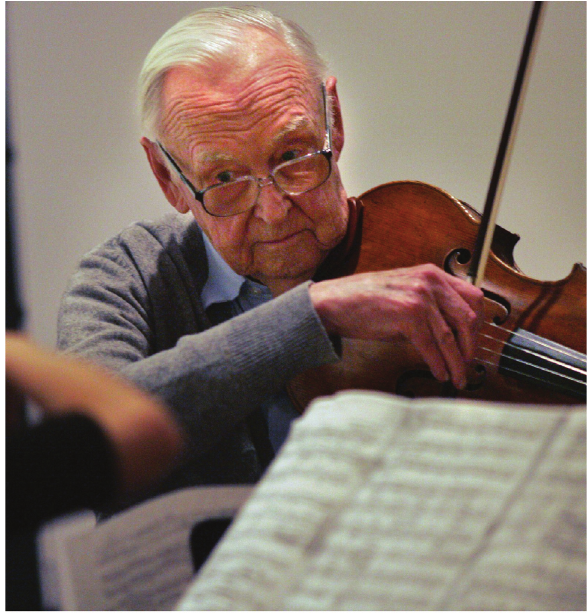
Figure 1 - James F. Crow on a concert he organized on occasion of his 90 th birthday. (Photograph by Craig Schreiner, reproduced with permission from Wisconsin State